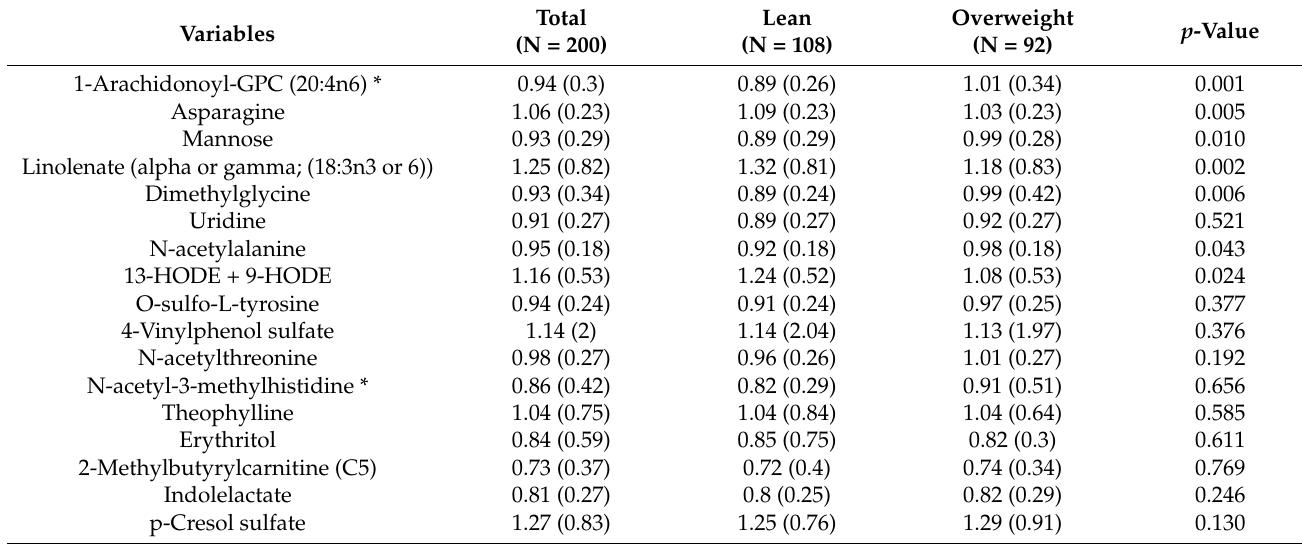
Table 3. CHD metabolites in apparently healthy lean, and overweight females. Data are presented as mean (SD). Differences between lean and overweight were tested by an independent sample t -test. A p -value level of 0.01 was used to infer significance. Accordingly, significant differences are highlighted. Asterisks (*) indicated on IDs of some metabolites refer to compounds that have not been officially confirmed based on a standard, but their identities are known with